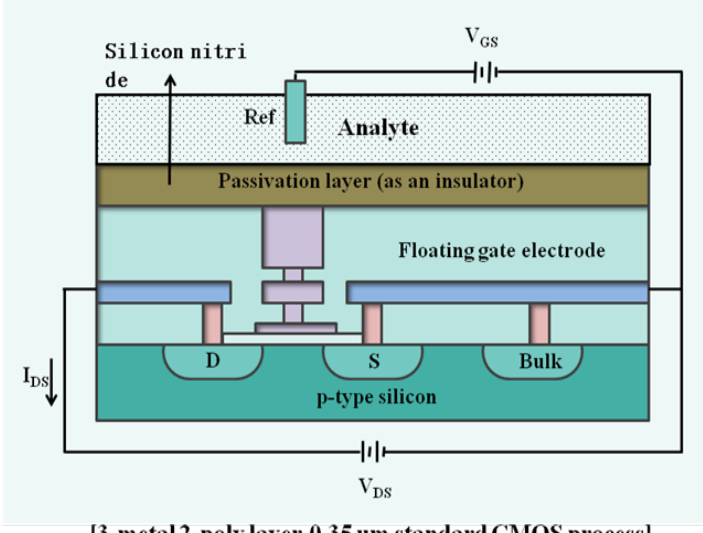
Figure 6. A cross-sectional diagram of an ISFET using an unmodified CMOS process